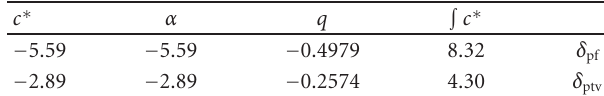
Table 6: Longitudinal feedback gain matrix K D .